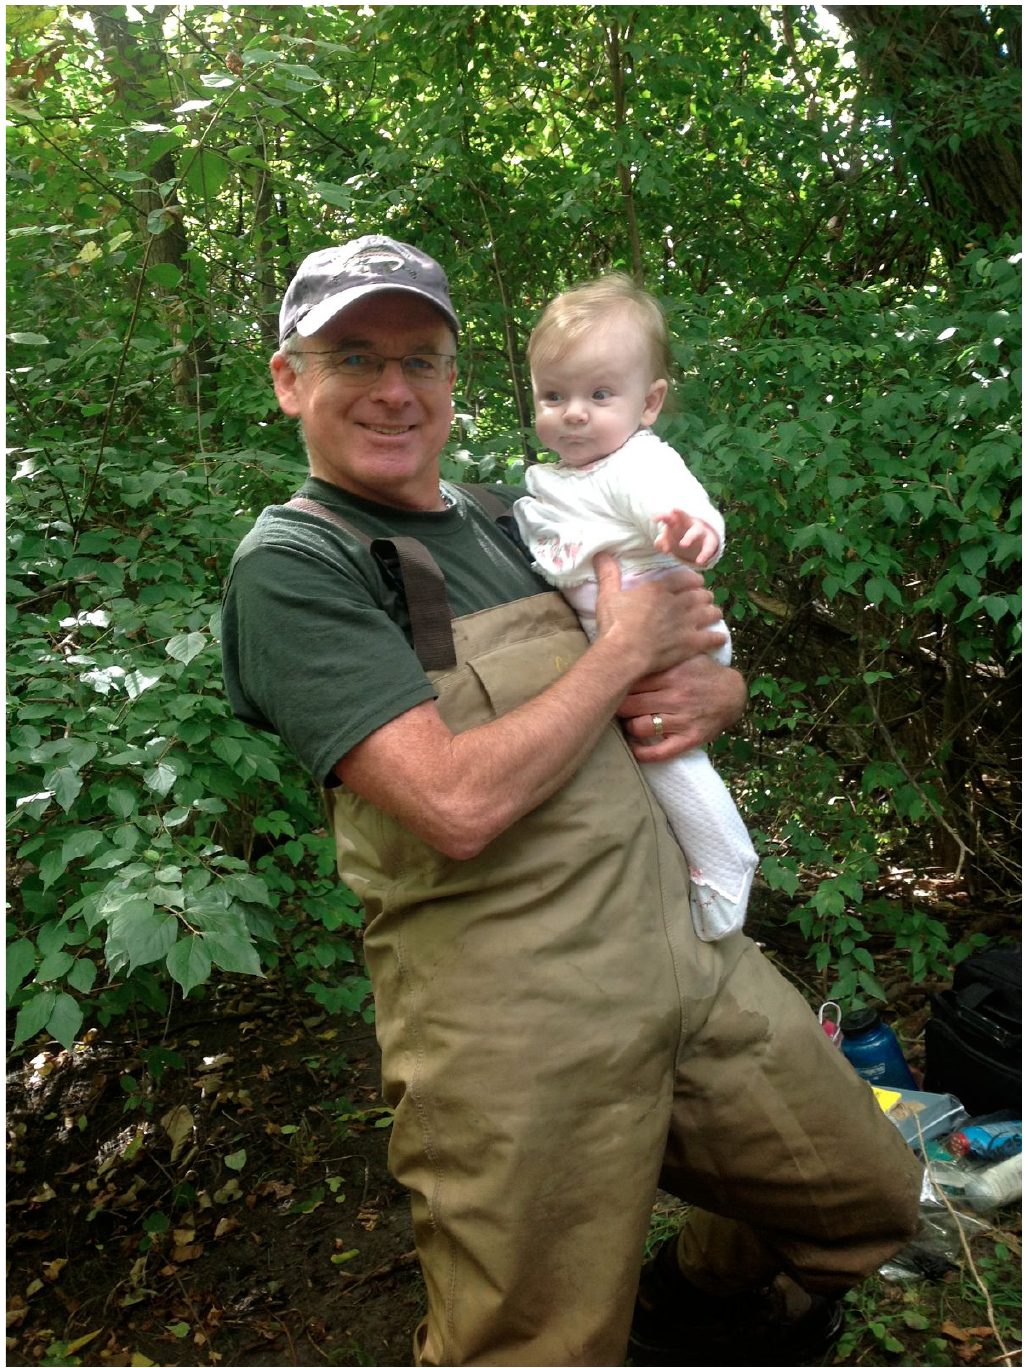
Figure A1.6. Even the youngest of crew members sacrificed their time to help the sampling effort, as 6­month­old Maria Shirey is held by Gary Lamberti on September 13, 2013 after a few hours of supervising fieldwork